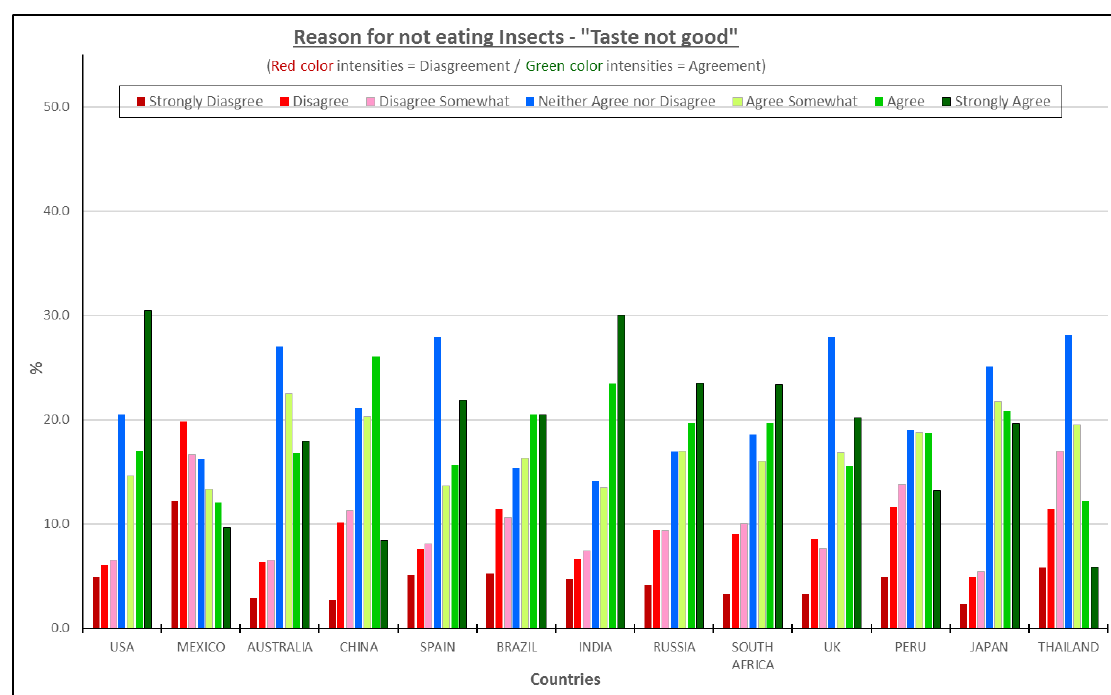
Figure 8. Reasons for not eating insect products—“I do not think it would taste good”.